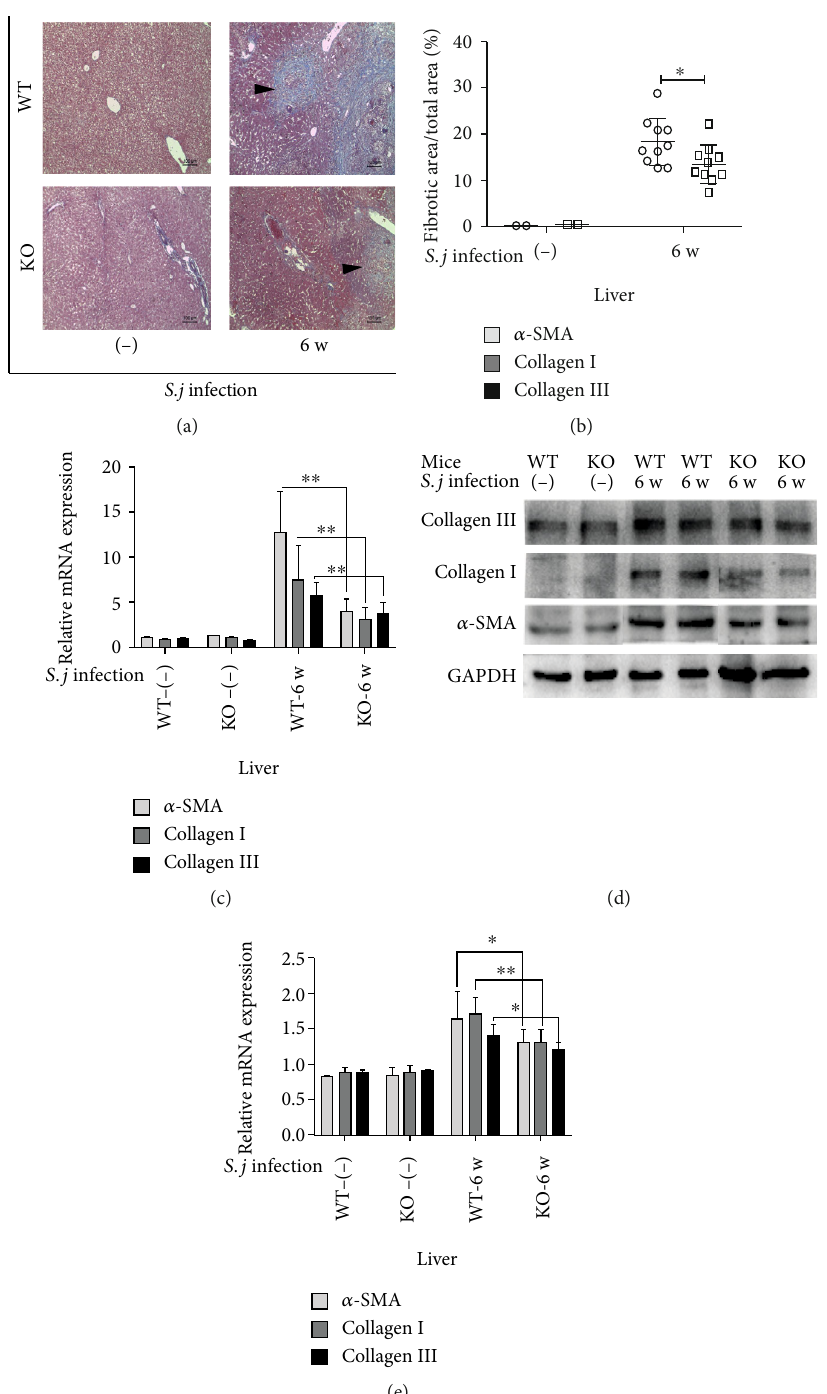
Figure 3: Changes in liver fi brosis in USP21 fl / fl FOXP3 cre mice infected with S. japonicum . (a – e) The livers were harvested from the mice on the 42 nd day after the infection and stained with Masson ’ s trichrome ( n = 10 animals/group). (a) Representative images of collagen deposition in the WT-INF and KO-INF mice (original magni fi cation: 100x) were obtained. The blue areas are collagen granules. (b) Comparison of the percentages of the hepatic fi brosis area between the WT-INF and KO-INF groups. The data are presented as the means ± SD , ∗ p = 0 : 039 . (c) Comparison of the levels the α -SMA, Collagen I, and Collagen III mRNAs in the WT and KO mice in the NC and INF groups. The data are presented as the means ± SD . Comparison of the levels of the α -SMA, Collagen I, and Collagen III mRNAs between the infected groups. The data are presented as the means ± SD . In the infection group, α -SMA: ∗∗ p < 0 : 001 ; collagen I: ∗∗ p = 0 : 008 , and Collagen III: ∗∗ p = 0 : 006 . (d) Representative images of SMA, Collagen I, and Collagen III protein expression in the WT and KO mice from the NC and INF groups, as determined by Western blotting. (e) Comparison of protein expression between WT and KO mice in the NC and INF groups. The data are presented as the means ± SD . In the infection group, α -SMA: ∗ p = 0 : 034 , Collagen I: ∗∗ p = 0 : 006 , and Collagen III: ∗ p = 0 : 03